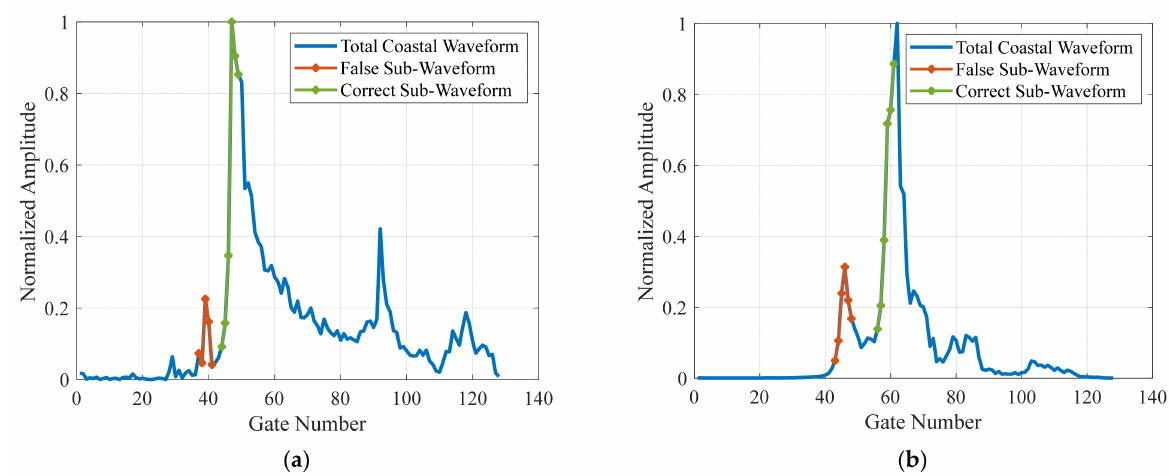
Figure 10. Two typical results of the NPPR algorithm in sub-waveform extraction ( a , b ). The blue curves represent the total coastal waveforms, the red curves represent the sub-waveforms determined to be false, and the green curves represent the sub-waveforms determined to be